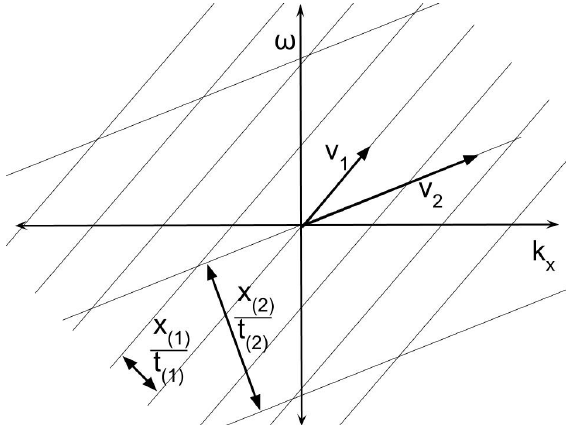
Figure 1. Discrete motion of a system. Convolution of a signal with an ideal detector is equivalent to a forward and inverse Fourier transform pair, which corresponds to a discrete update of spacetime coordinates. Shown here are two examples of such detections. For each, a phase factor applied in k µ -space corresponds to an infinite set of consistent, discrete spacetime displacements ( x ( i ) , t ( i ) ), associated with a well-defined velocity v i = ω ( i ) / k x ( i ) or classical "trajectory". The velocity is plotted against x µ -space axes (not